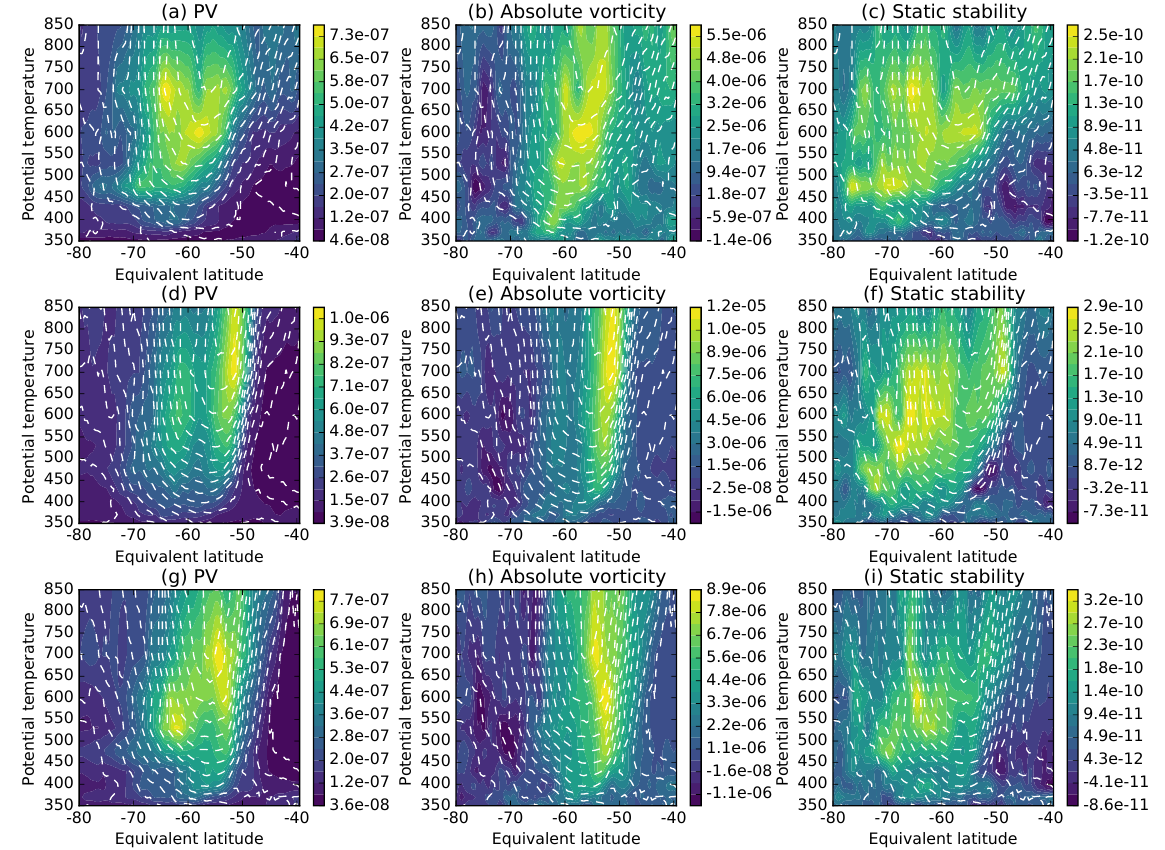
Figure 10. Gradients of PV, absolute vorticity and static stability with respect to EL for composites of years with elevated BI in selected months (a–c) July (1983, 1986, 1989, 1991, 2005), (d–f) August (1979, 2007, 2011, 2012, 2015) and (g–i) September (1980, 1981, 2011, 2012, 2015). See text for further explanation of method used to select